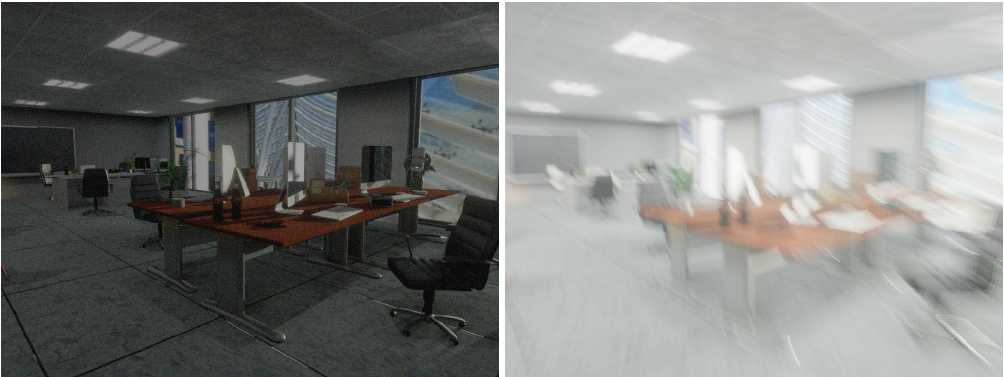
Figure 8. The left image is generated with f ps = 30 Hz and EV = − 3 (exposure time: 0.0029 s). The result is a noisy, low-intensity image; The right imageis generated with f ps = 120 Hz and EV = 1 (exposure time 0.0464 s). As a result, we obtain significant motion blur and higher